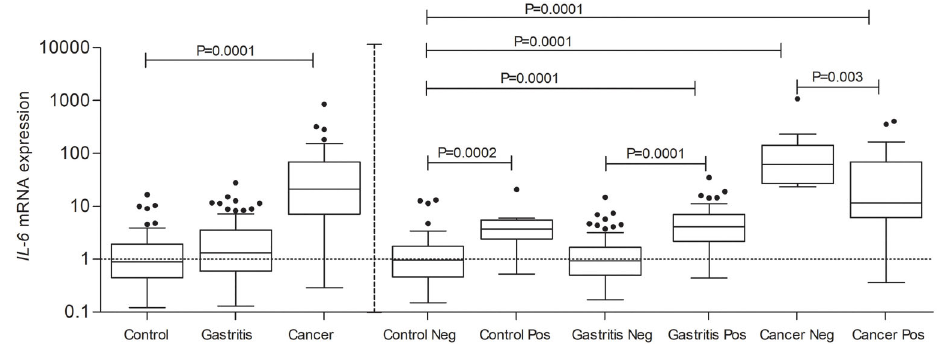
Figure 1. Analysis of interleukin ( IL-6 ) expression (percent of Control) in Control, Gastritis, and Cancer groups when the presence of H. pylori was not considered ( left ), and when it was considered ( right ). Data are reported as medians and interquartile range (ANOVA). Control neg and pos: normal gastric tissue without gastritis or in fl ammatory process and negative or positive for H. pylori infection; Gastritis neg and pos: patients with gastritis and negative or positive for H. pylori ; Cancer neg or pos: patients with cancer and negative or positive for H. pylori